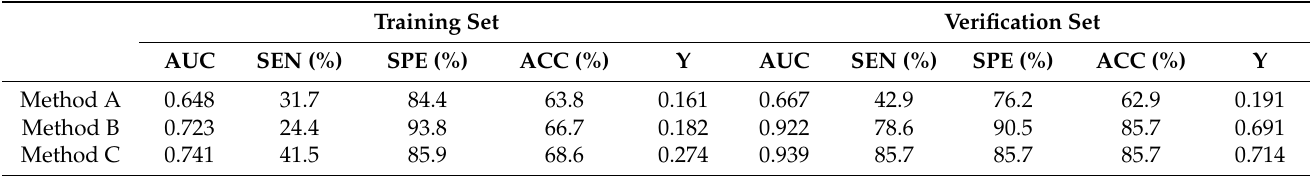
Table 4. Diagnostic performance of the